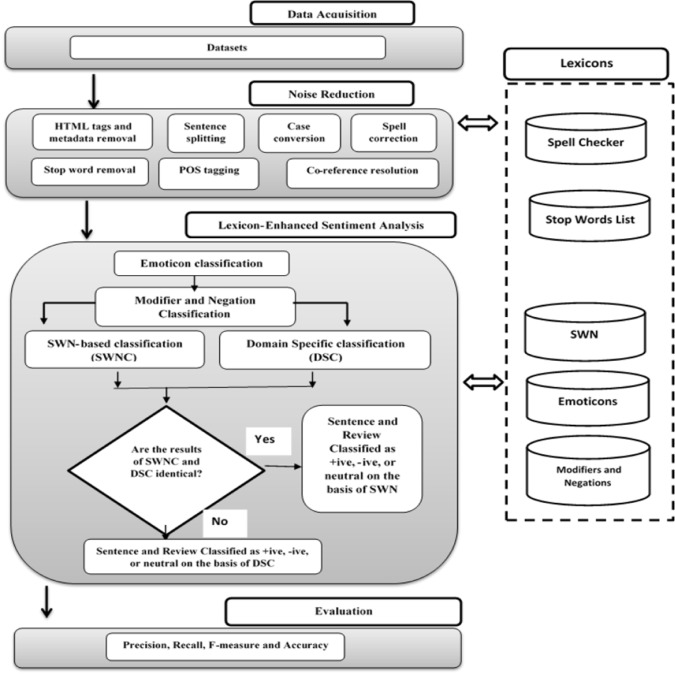
Proposed System.